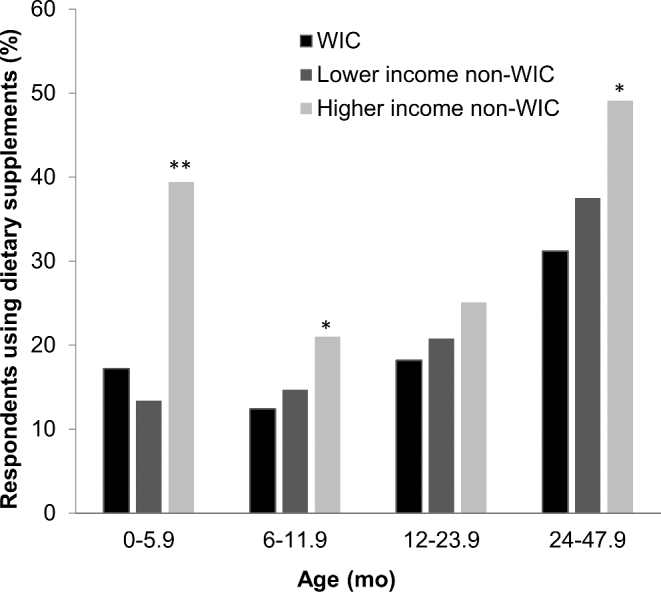
Prevalence of dietary supplement use by WIC participation and income: FITS 2016. Chi-square tests for differences across WIC categories within age group were conducted. *P < 0.05, **P < 0.001. FITS, Feeding Infants and Toddlers Study; WIC, Special Supplemental Nutrition Program for Women, Infants, and Children.